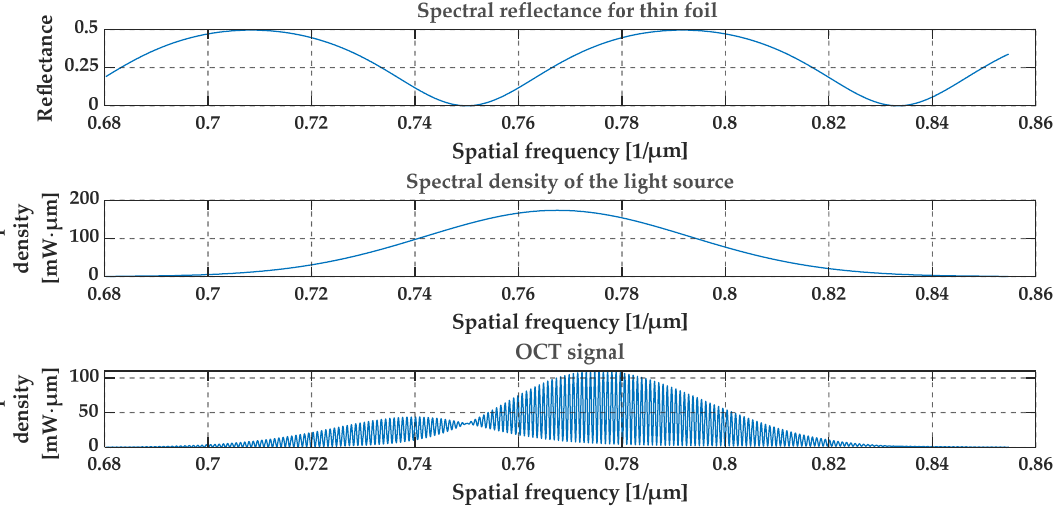
Figure 4. Theoretical spectral characteristics obtained from a thin foil of diamond. The thickness of the foil is 2.5 µm and the depth of the layer is 0.25 mm. Refractive indexes are n 1 = 1, n 2 = 2.4, n 3 = 1.